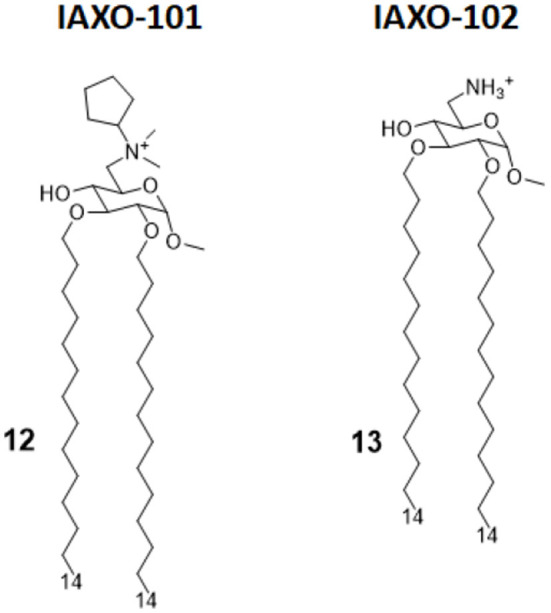
IAXO-101 and IAXO-102 are glycolipid compounds bearing a positive charge. They form stable aggregates with LPS and compete with LPS for TLR4 binding.